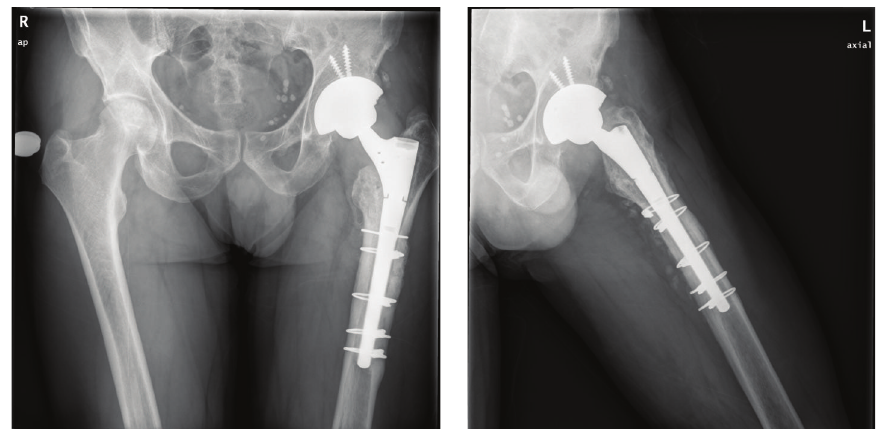
Figure 3: Plain radiographs of the pelvis showing a straight Revitan revision prosthesis (Zimmer, Warsaw, IN) and a TMT revision cup (Zimmer, Warsaw, IN) with press fit and two cancellous screws; the trochanteric osteotomy was synthetized with 4 cerclage